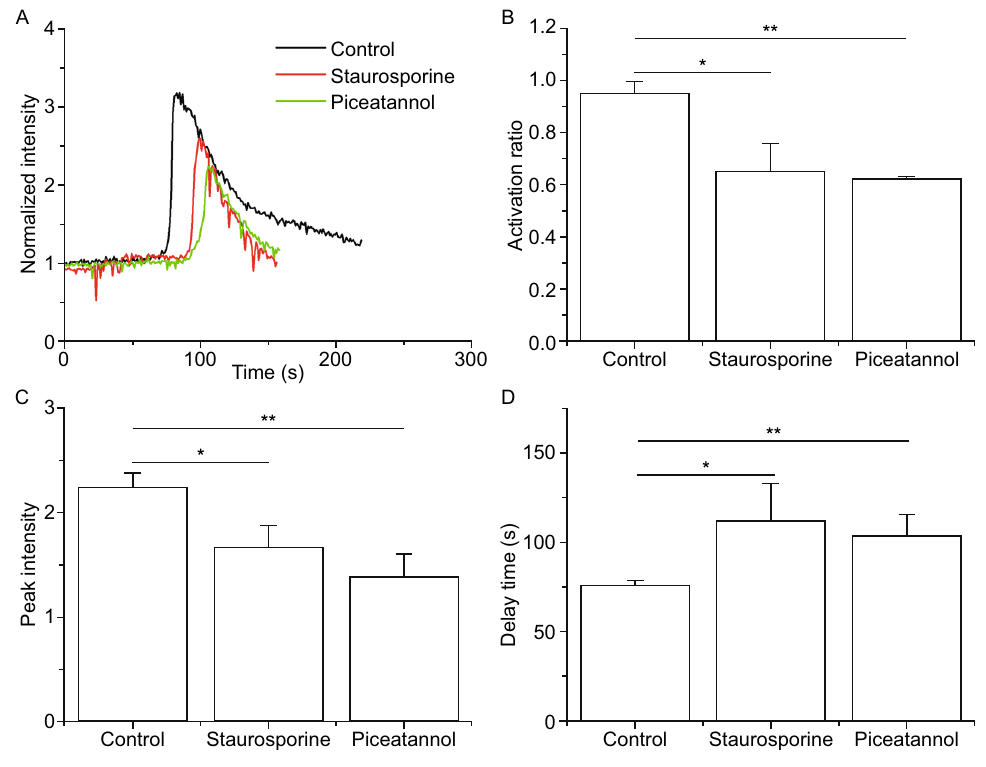
Figure 7. Effects of blockage of moesin and Syk on P-selectin induce-calcium signaling in neutrophils in fl ow. The time- course (A), activation ratio (B), peak intensity (C) and delay time (D) of P-selectin-induced calcium signaling of neutrophils, treated with or without moesin inhibitor staurosporine and Syk inhibitor piceatannol, at a wall shear stress of 0.2 Pa. The data represent the mean ± SEM from at least 20 cells in 3 independent experiments. The signi fi cant level of difference from control group (the cells treated with nothing) is shown by P -value, * P < 0.05, ** P <